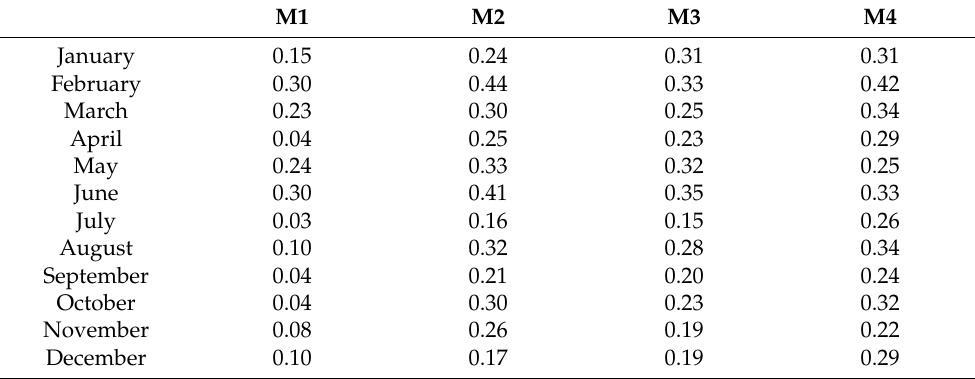
Table 7. Values of the Spearman’s rho correlation coefficient between the value of the volume of electricity consumed and horizontal insolation in the individual months in 4 analyzed cases of